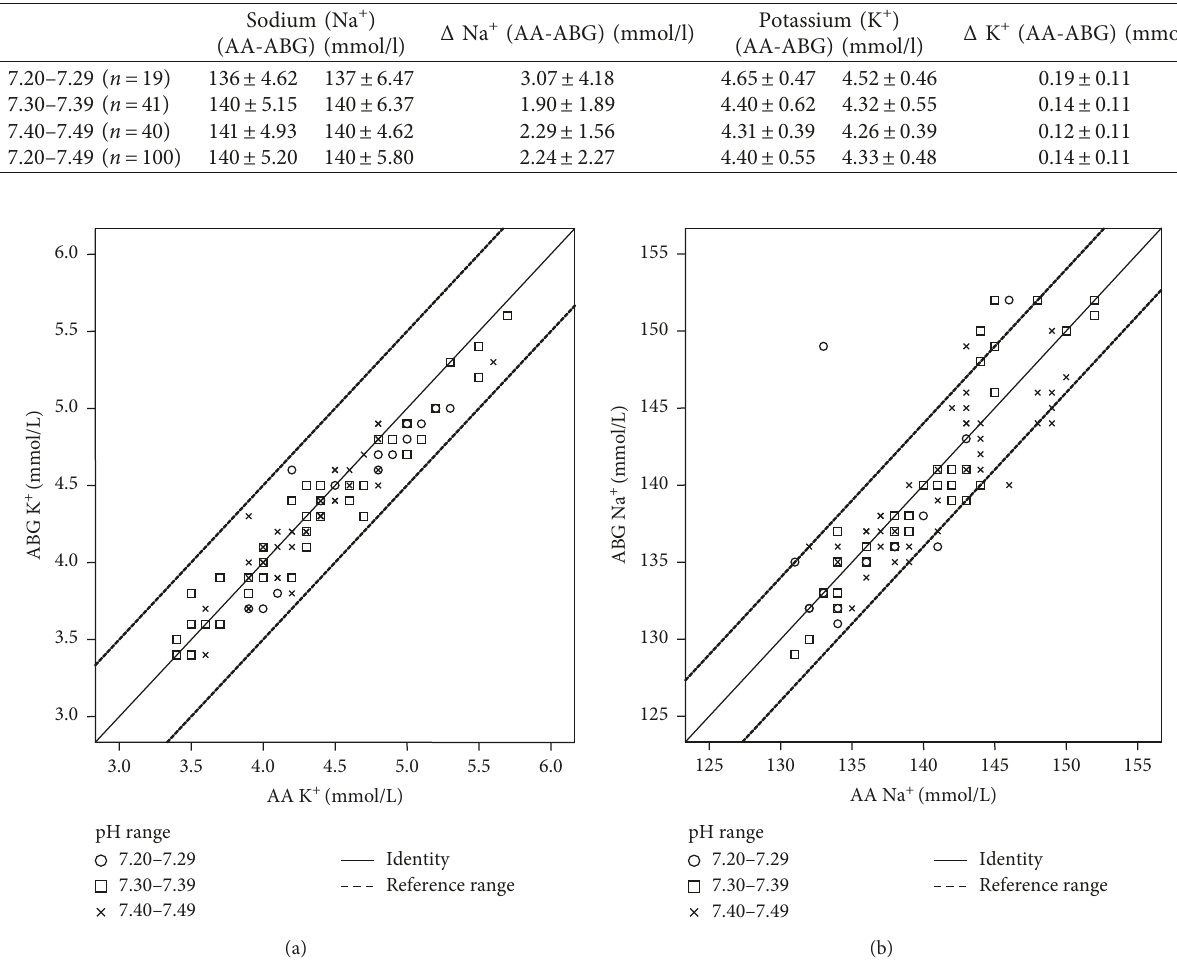
Table 1: Differences in measurements of sodium and potassium in the ABG and AA at different pH values.